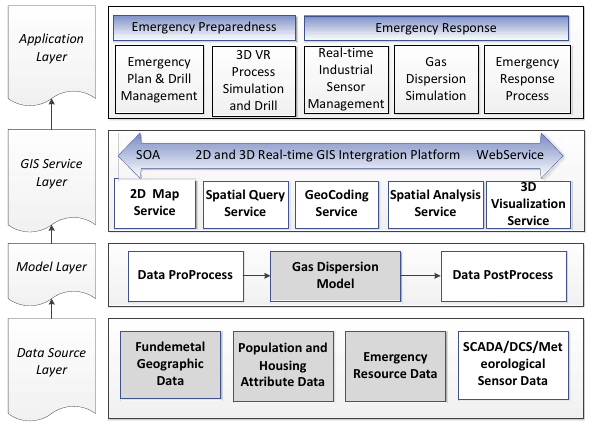
Figure 1. The architecture of Emergency